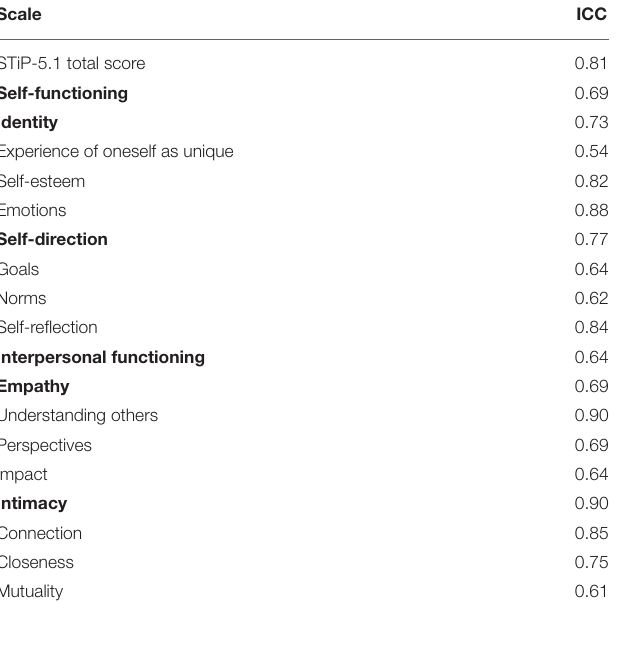
TABLE 2 | Inter-rater reliability: ICC per facet, aspect, and domain of STiP 5.1 ( N 29). =